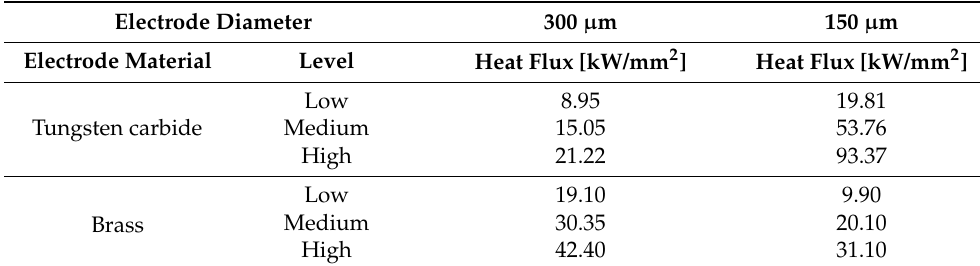
Table 4. Parameters setup for the FEM simulation tests.